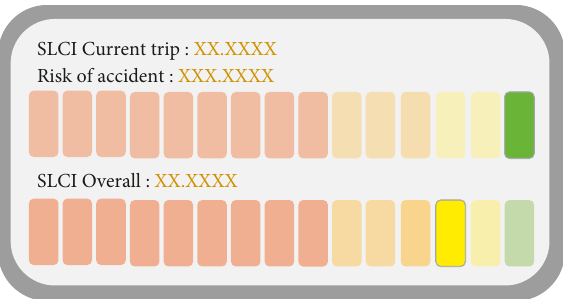
Figure 7: A schematic of SLCI and speed risk